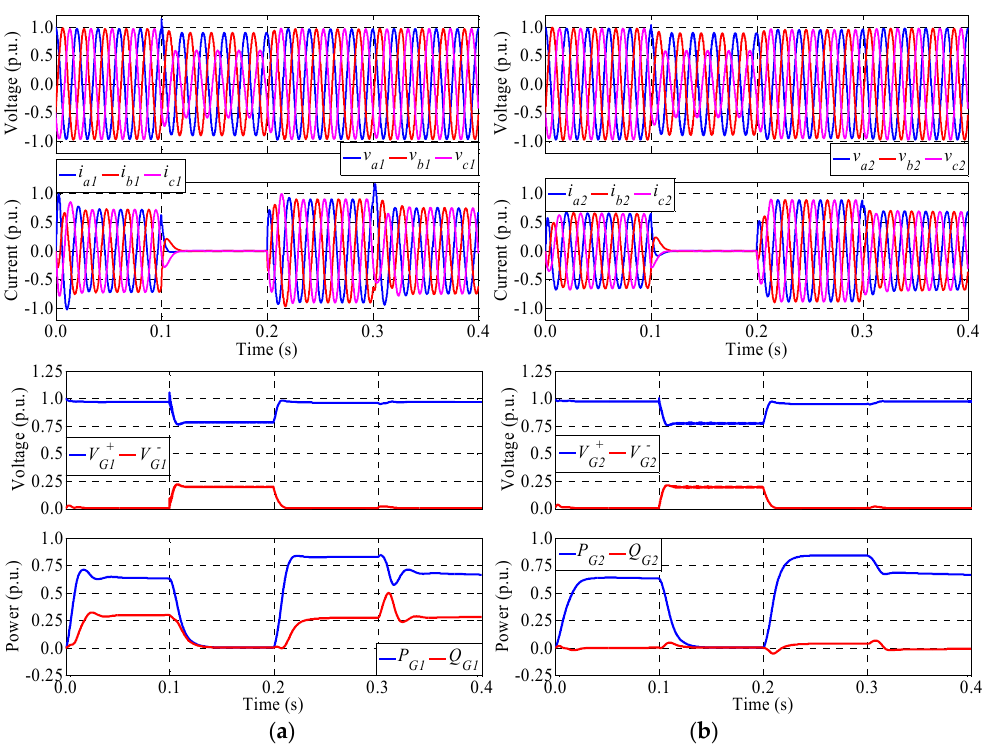
Figure 8. Main waveforms of ( a ) generator 1 and ( b ) generator 2 using the GCCS3 control scheme for type I voltage sag.